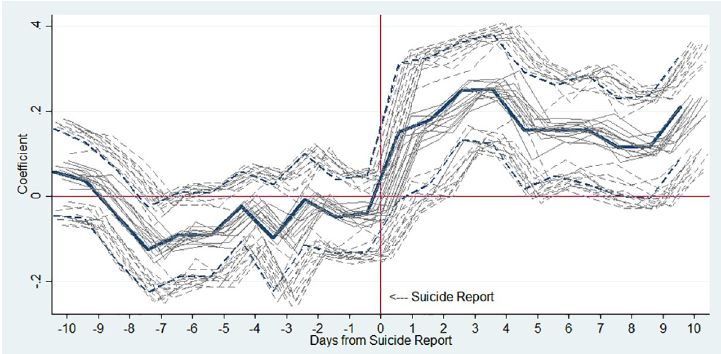
Fig 10. Estimated changes in total suicides before and after media reports on celebrity suicide. Note: The thick blue line is the main result of the top panel of Fig 2 using all 13 celebrity suicides. The light gray lines each represent results from 12 celebrity suicides after omitting each of the 13 celebrity suicides. The y -axis indicates an approximate percent change in public suicide by corresponding day, which is the estimated β 95% confidence